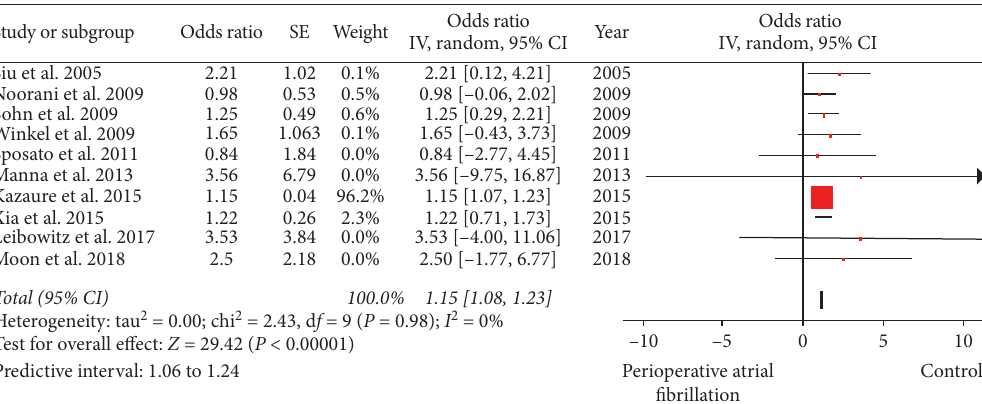
Figure 4: Forest plot evaluating hypertension as a risk factor for perioperative atrial fibrillation in patients undergoing noncardiothoracic surgery. The odds ratio of each included study is plotted. A pooled estimate of overall odds ratio (diamonds) and 95% confidence intervals (width of diamonds) summarizes the effect size using the random effects model. CI � confidence interval; M–H � Mantel–Haenszel; OR � odds ratio; I 2 : heterogeneity; P < 0 . 05 is